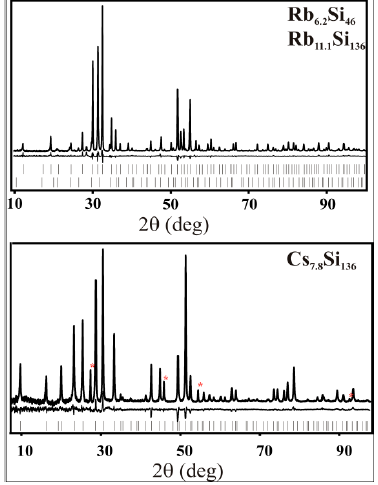
Figure 4. Powder X-ray diffraction (PXRD) patterns of the Rb 6.2 Si 46 and Rb 11.1 Si 136 mixed product and clathrate-II Cs 7.8 Si 136 . The experimental intensities are shown as a solid line. The differences between